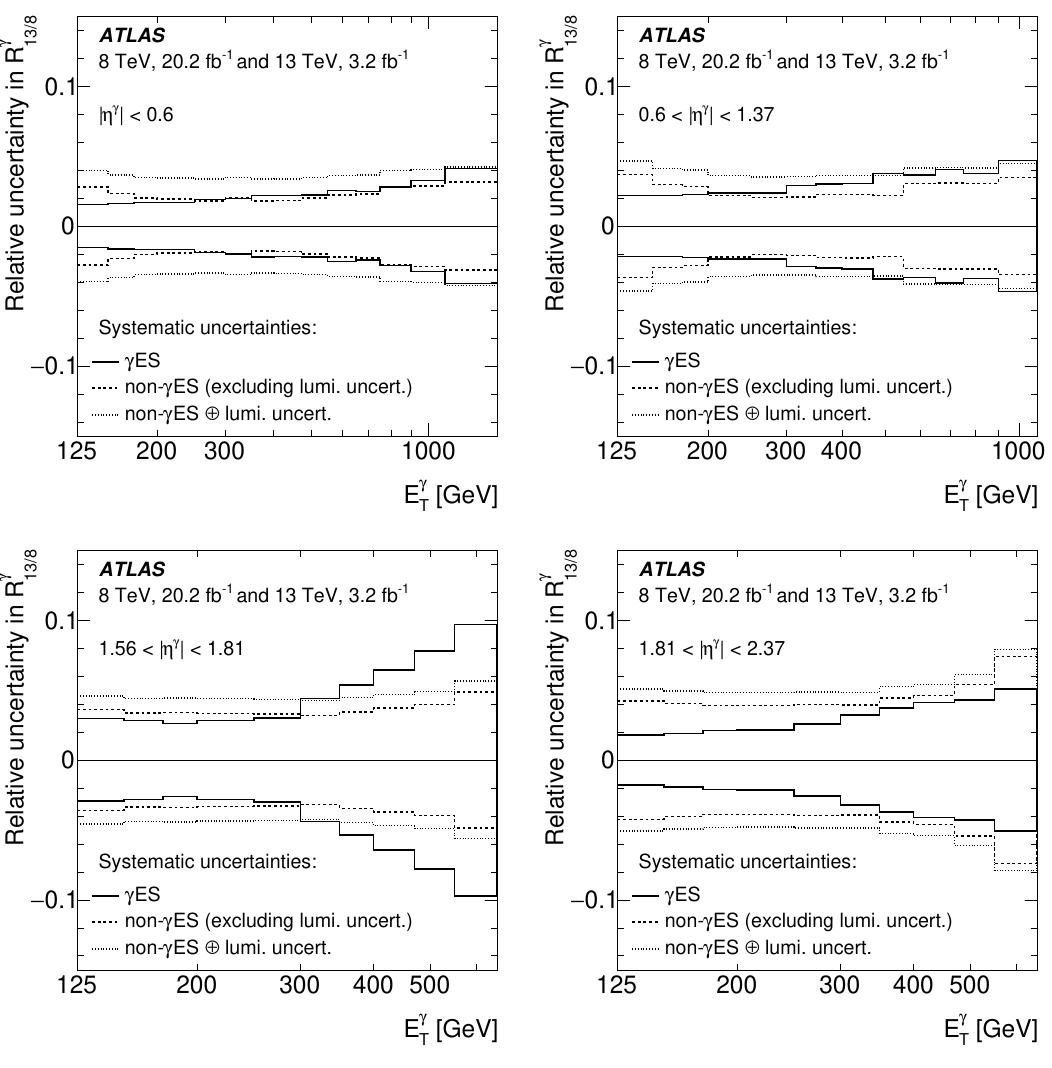
Figure 3 . Relative systematic uncertainty in R (cid:13) due to di(cid:11)erent sources: (cid:13) ES uncertainties (solid lines), non- (cid:13) ES uncertainties excluding the luminosity uncertainty (dashed lines) and non- (cid:13) ES and luminosity uncertainties added in quadrature (dotted